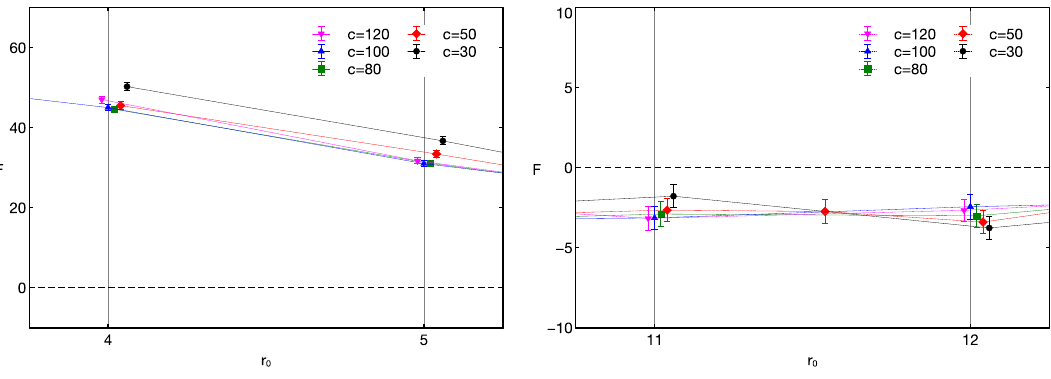
Figure 9 . Monte Carlo history (binned in blocks of 40 samples for clarity) and histogram of the two observables r M =1 and r M =2 de(cid:12)ned in (3.2) at r 0 = 7 : 0, for N = 8, L = 8 and T = 3 : 0. On each plot we show two values of c , c = 50 and c = 100. The blue dotted line in the left plot corresponds to r 0 = 7, while on the right plot it corresponds to zero.